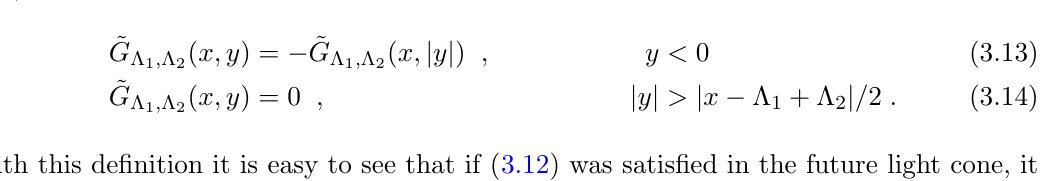
Figure 4 . We have to impose the boundary condition ~ G (cid:3) ( x; y ) = 1 on the light-rays intersecting 1 ; (cid:3) 2 at x = (cid:3) 1 (cid:0) (cid:3) 2 and given by the equation x = (cid:3) 1 (cid:0) (cid:3) 2 (cid:6) 2 y . The initial function ~ G (cid:3) only de(cid:12)ned inside the future light cone. It can be extended to the whole plane by setting it to zero outside the light cone and imposing ~ G (cid:3) ( x; y ) = (cid:0) ~ G (cid:3) ( x; (cid:0) y ) for negative y . 1 ; (cid:3) 2 1 ; (cid:3) 2 for (cid:0) (cid:3) < (cid:3) and (cid:0) (cid:3) < (cid:3) i.e. inside the future light-cone, see (cid:12)gure 4. We 1 3 2 4